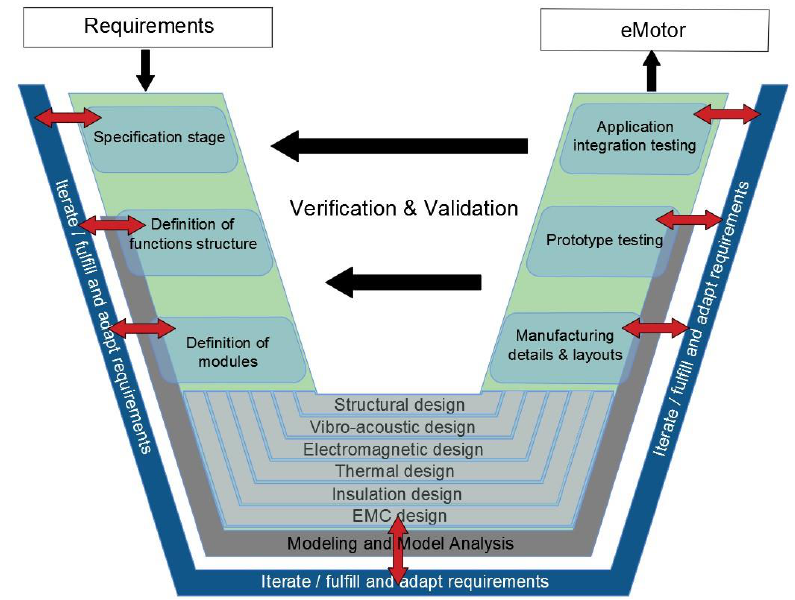
Figure 3. Industrial V-model for the development of electric machines.